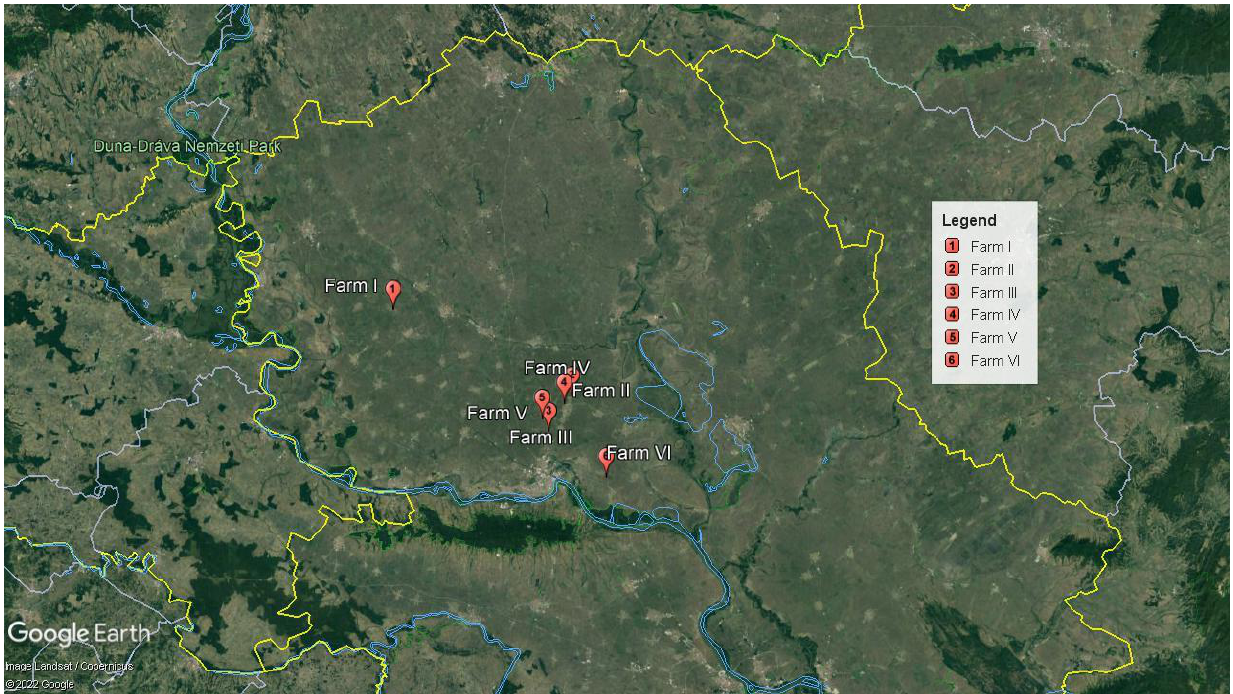
Figure 1. Map of Vojvodina province and locations of the affected farms. Distance from Farm I to Farm II was 46.00 km; from Farm II to Farm III was 9.46 km; from Farm III to Farm IV was 7.38 km; from Farm IV to Farm V was 6.17 km; from Farm V to Farm VI was 19.92 km. The sequence of occurrence of ILT on the farms follows the numerical designation of the farm (Farm I is the first affected and Farm 6 is the last affected). Estimated poultry population in this area is as follows: layer hens 1,481,000; broiler breeders 260,000 and broilers 1,200,000. Data about infected flocks (type of farm, genetic line, age, reared system, number